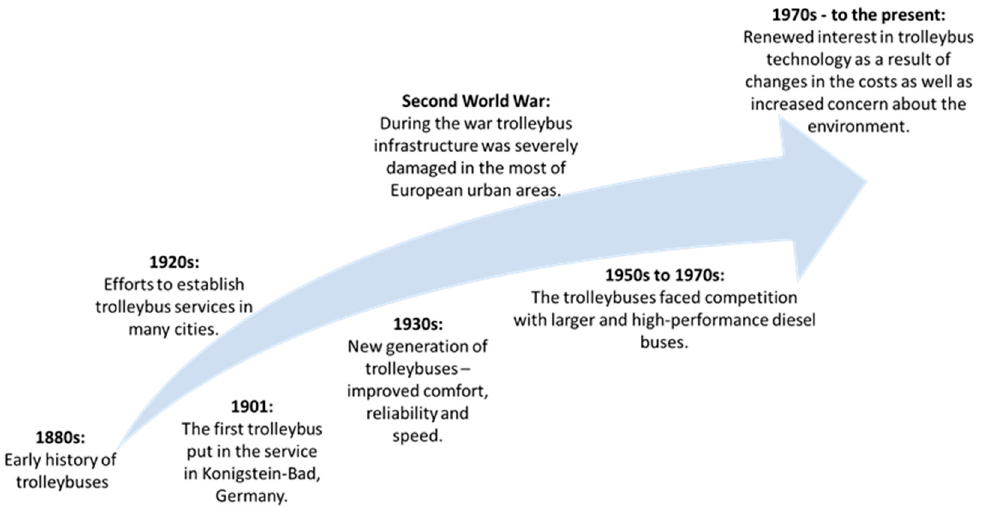
Figure 7. The major milestones in the development of